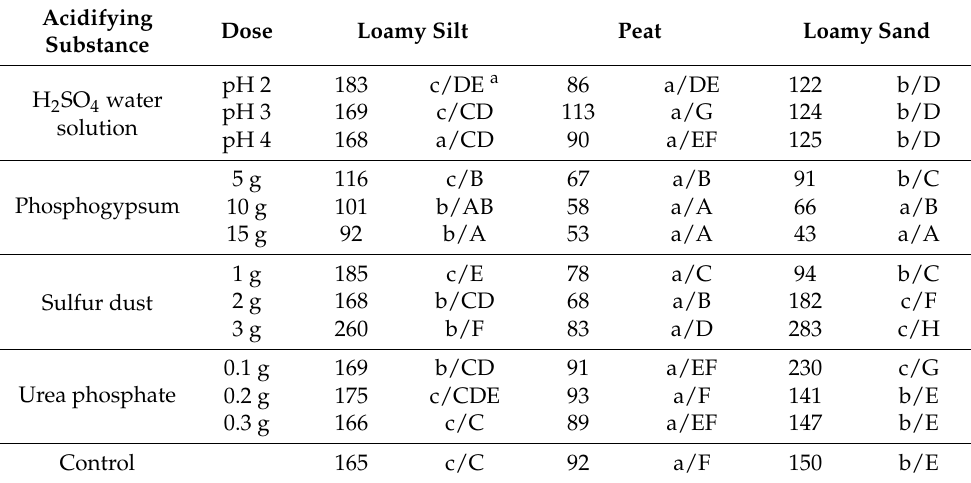
Table 6. Effects of acidifying substances after 12 months on the content of available magnesium in loamy silt, peat and loamy sand